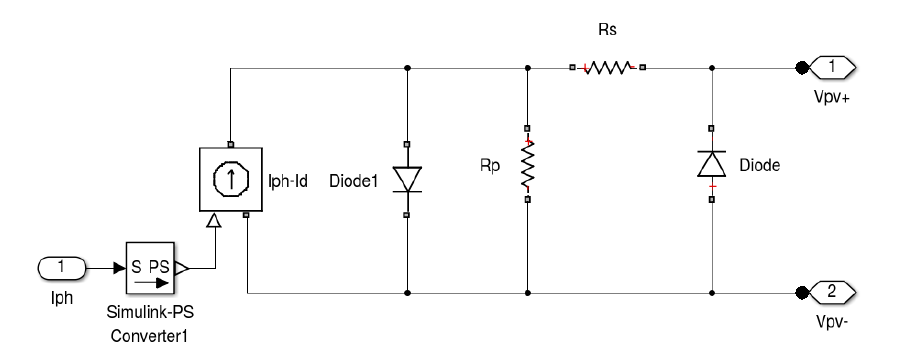
Figure 14. Circuit model of a PV panel of a diode applied in simulink @ .